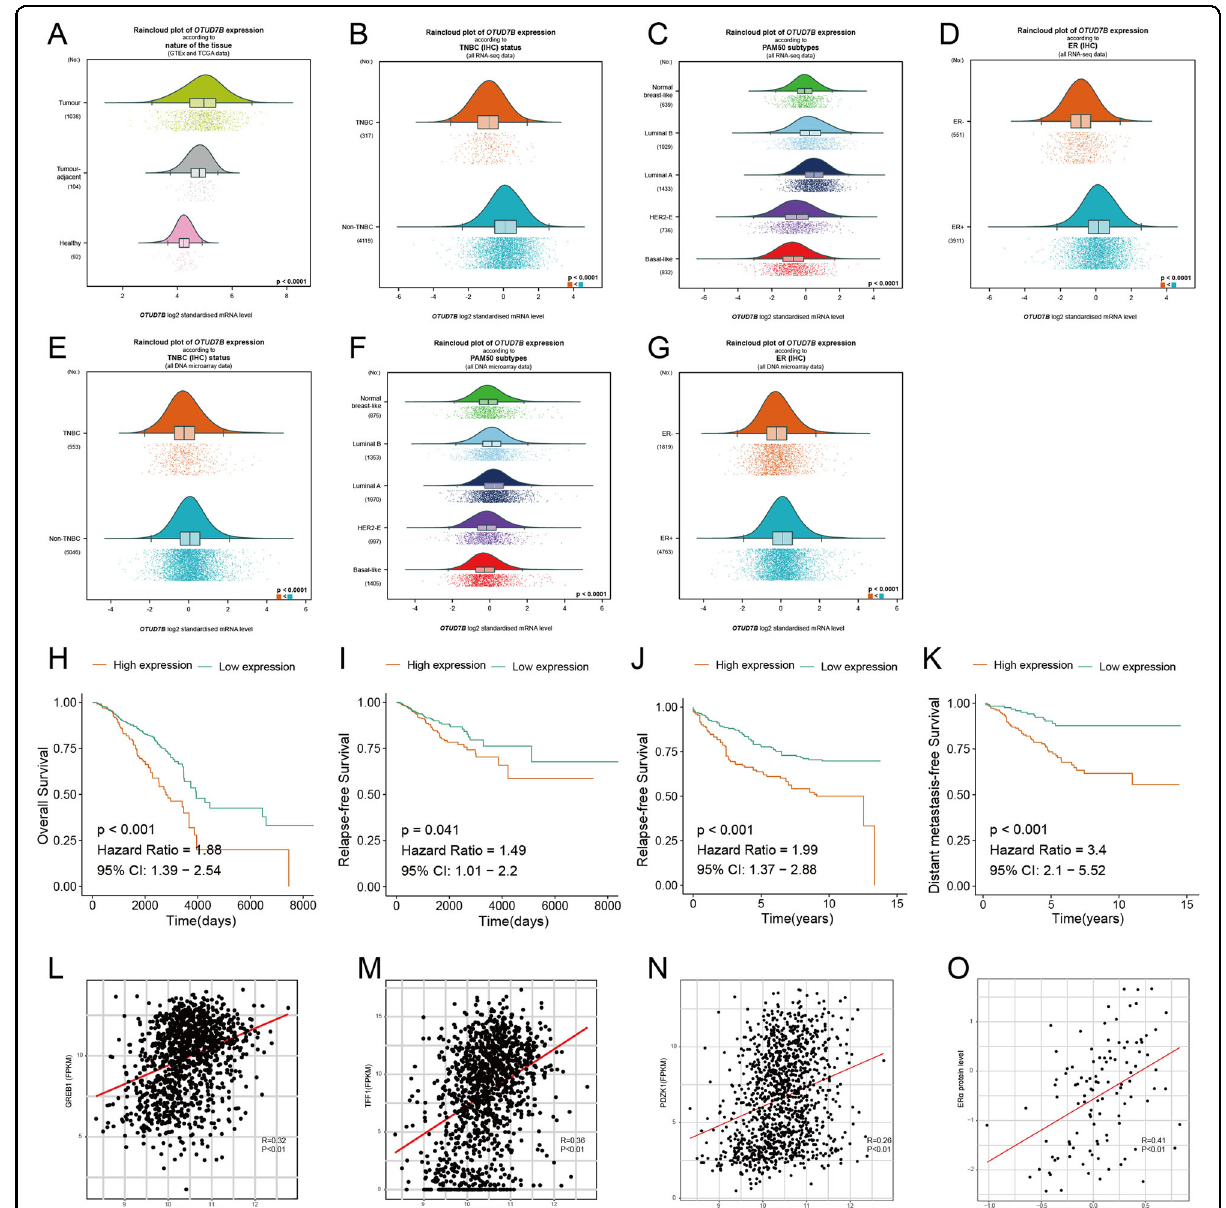
Fig. 2 OTUD7B is overexpressed in breast cancer and correlates with poor prognosis. A – G Expression of OTUD7B in breast cancer. A – D : Patients were extracted from TCGA BRCA dataset. E – G: Patients were extracted from microarray datasets. All data are available at bc-GenExMiner v4.5 (http://bcgenex.centregauducheau.fr/BC-GEM/GEM-Accueil.php?js = 1). The signi fi cance of differences was calculated using one-way ANOVA test. H , I OTUD7B is associated with poor overall survival and relapse-free survival of breast cancer patients in TCGA. Cox proportion hazards model was used to understand the signi fi cance between two groups. J , K OTUD7B was associated with poor relapse-free survival and distant metastasies-free survival of ER α -positive breast cancer patients in GSE6532. Cox proportion hazards model was used to clarify the signi fi cance between two groups. L – N Correlations between OTUD7B and ER α target genes in TCGA (Pearson correlation). O Correlations between OTUD7B and ER α protein levels in CPTAC (Pearson correlation). * P value < 0.05, ** P value < 0.01, *** P value <